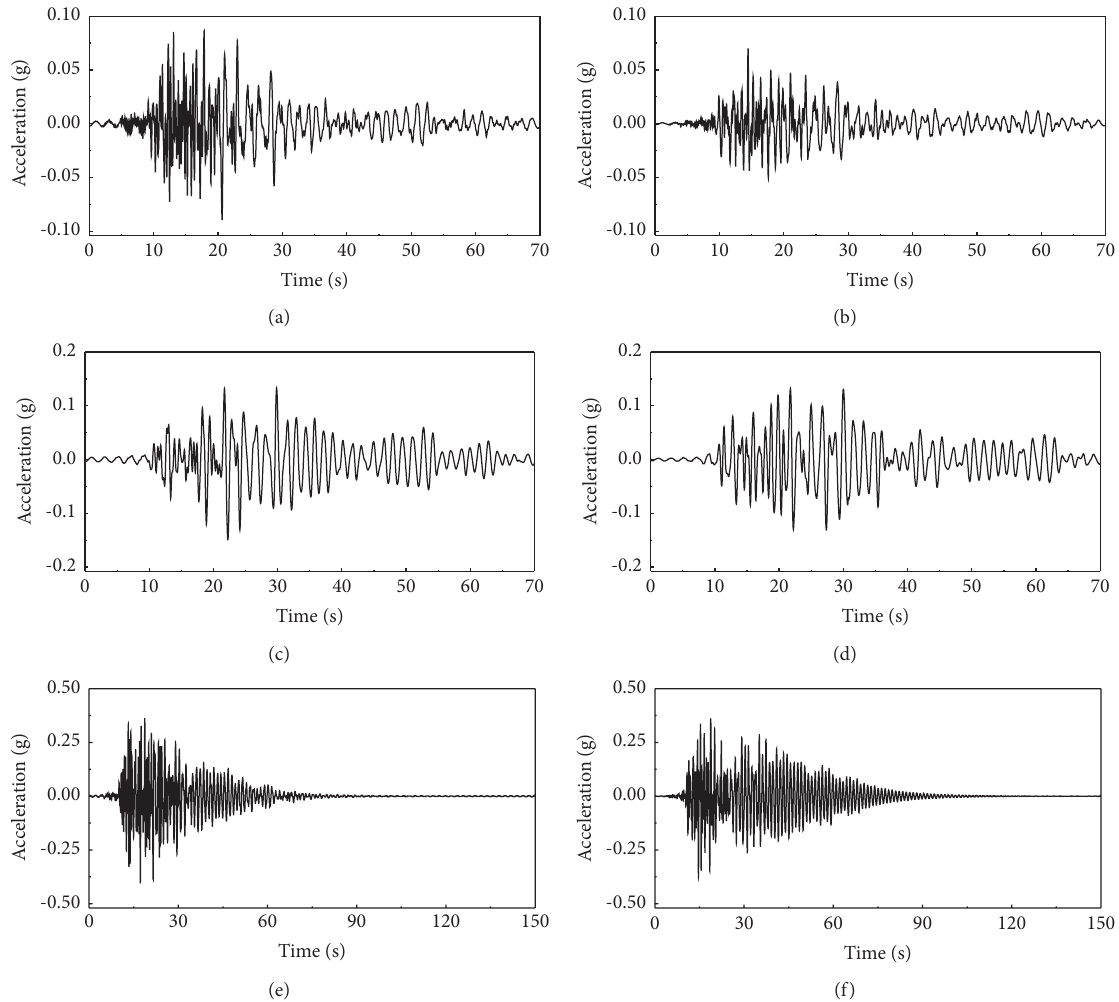
Figure 10: Floor acceleration time history. (a) SHW6 (5/128) wave in X direction, (b) SHW6 (5/128) wave in Y direction, (c) SHW6 (128/128) wave in X direction, (d) SHW6 (128/128) wave in Y direction, (e) SHW6 (30/30) wave in X direction, and (f) SHW6 (30/30) wave in Y direction. Table 1: Details of motions input to the specimen and peak floor acceleration of platform. Run no.